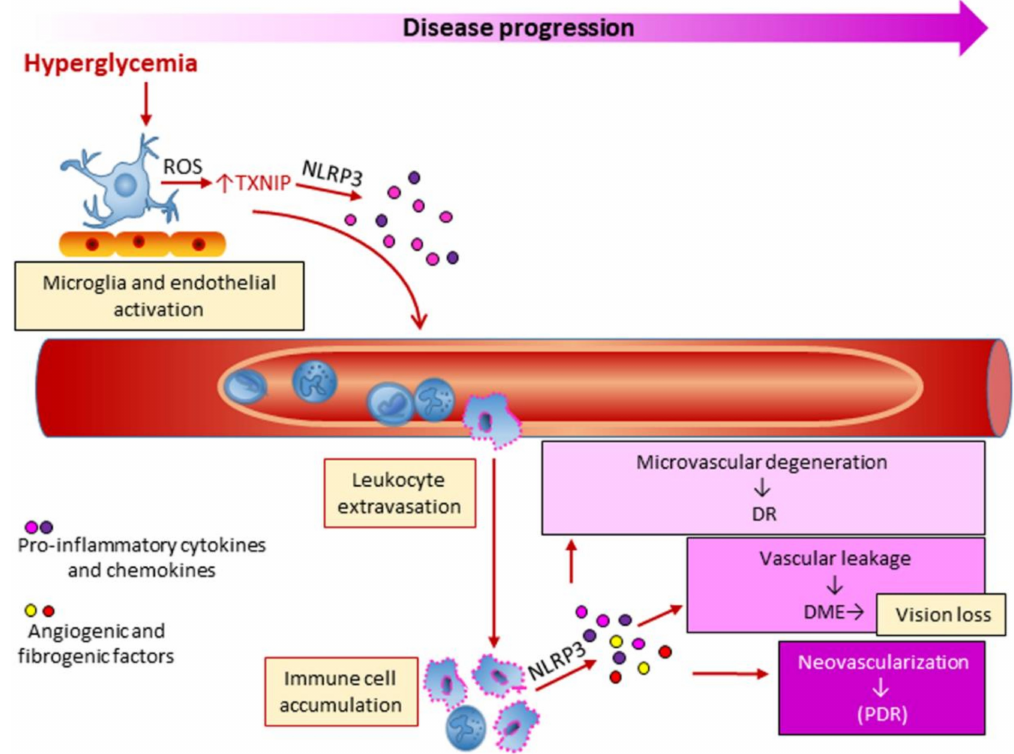
Figure 5. Role of inflammation and inflammasome NLRP3 activation in the early and advanced stages of diabetic retinopathy. ROS = radical oxygen species; TXNIP = thioredoxin interacting protein; DR = diabetic retinopathy; DME = diabetic macular edema; PDR = proliferative